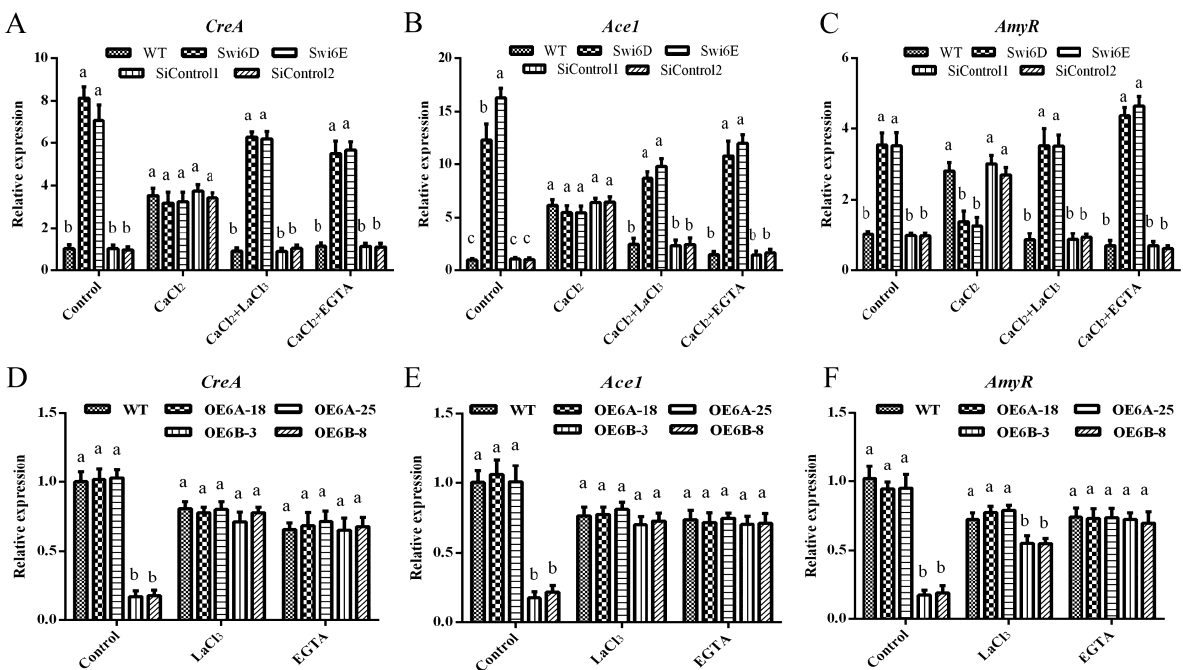
Figure 5. Intracellular Ca 2+ is involved in regulating the expression of CreA , Ace1 , and AmyR by GlSwi6. G. lucidum cultured in CYM liquid medium for 5 days were transferred to MM medium using cellulose as the sole carbon source and then treated with 5 mM CaCl 2 , LaCl 3 , or EGTA, respectively, for 24 h. ( A , D ) The expression of CreA in GlSwi6-silenced strains and GlSwi6 overexpression strains. ( B , E ) The expression of Ace1 in GlSwi6-silenced and overexpression strains. ( C , F ) The expression of AmyR in GlSwi6-silenced and overexpression strains. The values are the mean ± SE ( n = 3). Different letters indicate significant differences between the strains ( p < 0.05, Tukey′s test).